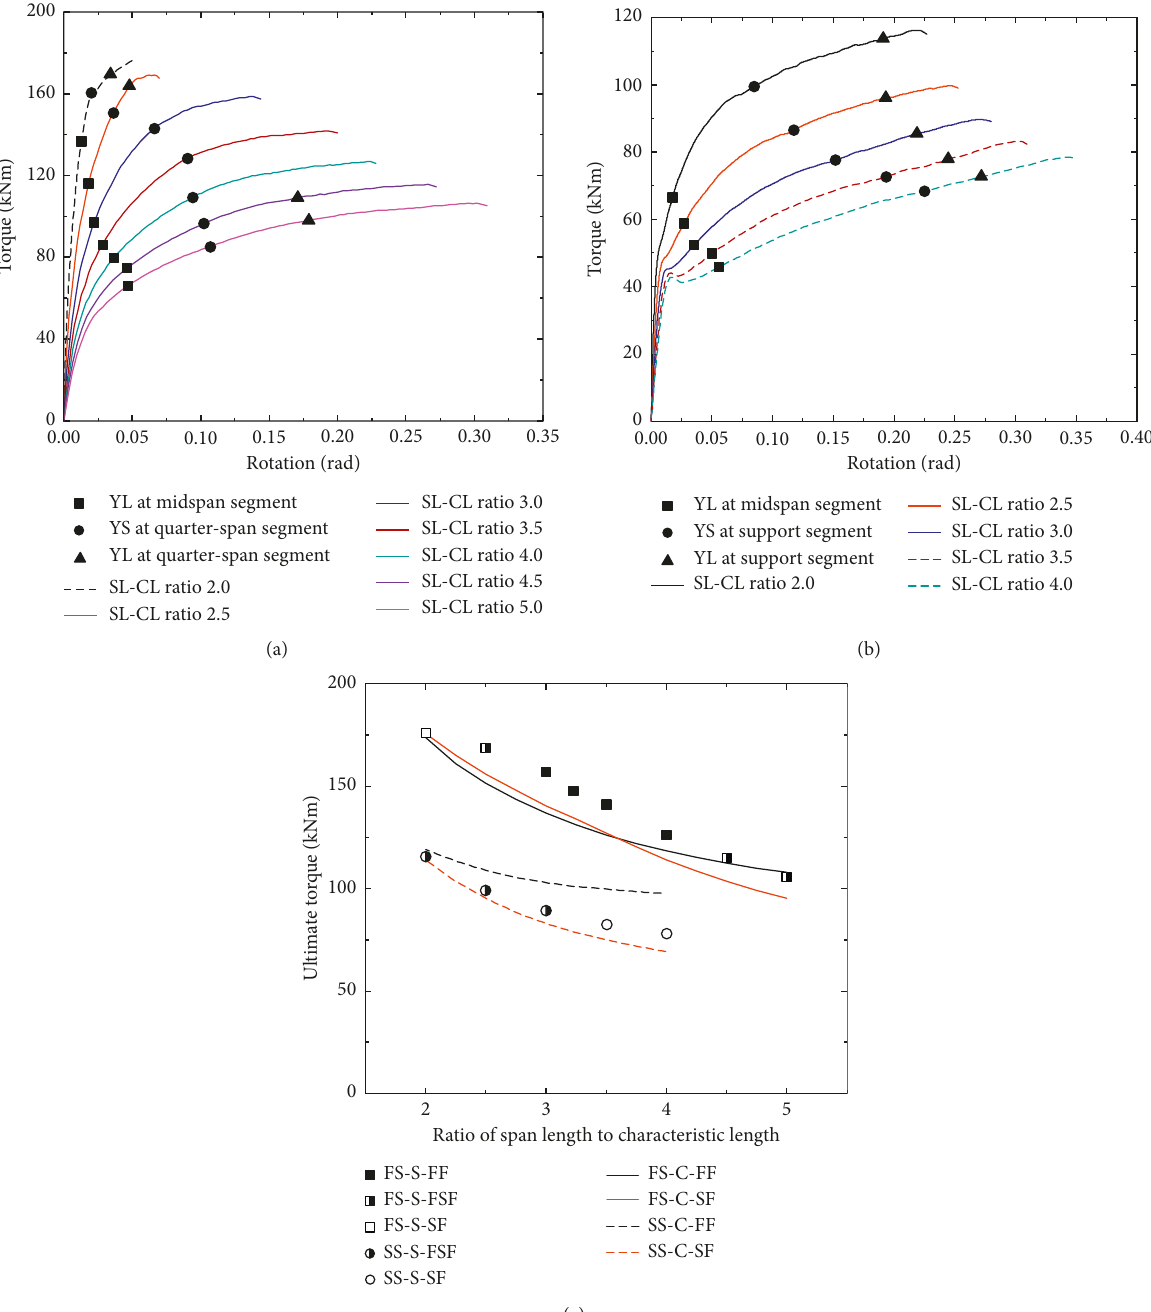
Figure 15: Simulated and calculated results of girders with various span lengths under different boundary conditions: (a) torque-rotation curves under fixed-fixed supporting, (b) torque-rotation curves under simple supporting, and (c) simulated and calculated failure modes and ultimate torques. In (a) and (b), “SL-CL ratio” means span length-characteristic length ratio; “YL” and “YS” mean yielding of longitudinal bars and yielding of stirrups, respectively. In (c), the first abbreviation “FS” and “SS” means fixed-fixed supported and simply supported, respectively; the second abbreviation “C” and “S” means calculated and simulated, respectively; and the third abbreviation “FF,” “SF,” and “FSF” means flexural failure, shear failure, and flexural-shear failure,